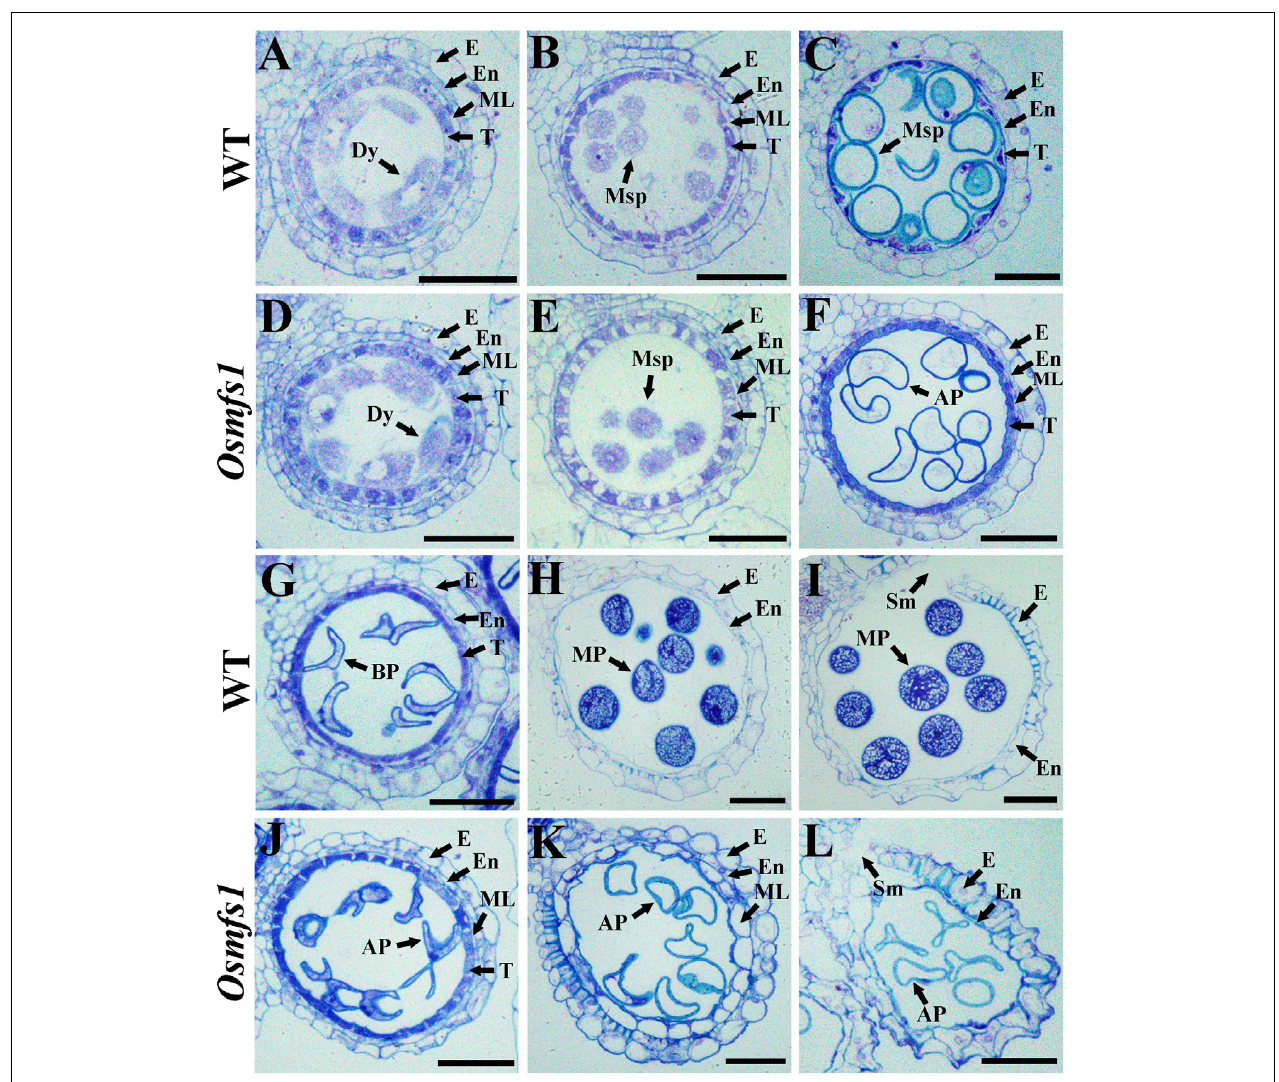
FIGURE 2 | Semi-thin section comparison of anther development in the WT and the Osmfs1 mutant. Transverse section of WT and Osmfs1 anthers were stained with toluidine blue. The images are of cross sections through single locules and pictures are captured with a 40 × ordinary optical microscope. (A–C) and (G–I) the WT anthers; (E,F,J , L) the Osmfs1 anthers; (A,D) Meiosis stage. (B,E) Early microspore stage. (C,F) Vacuolated pollen stage. (G,J) Bicellular pollen stage. (H,K) Mature pollen stage. (I,L) Anther dehiscence stage. E, epidermis; En, endothecium; ML, middle layer; T, tapetum; Dy, dyad cell; Msp, microspore; BP, bicellular pollen; AP, abnormal pollen; MP, mature pollen; Sm, stomium. Bars = 1 µ